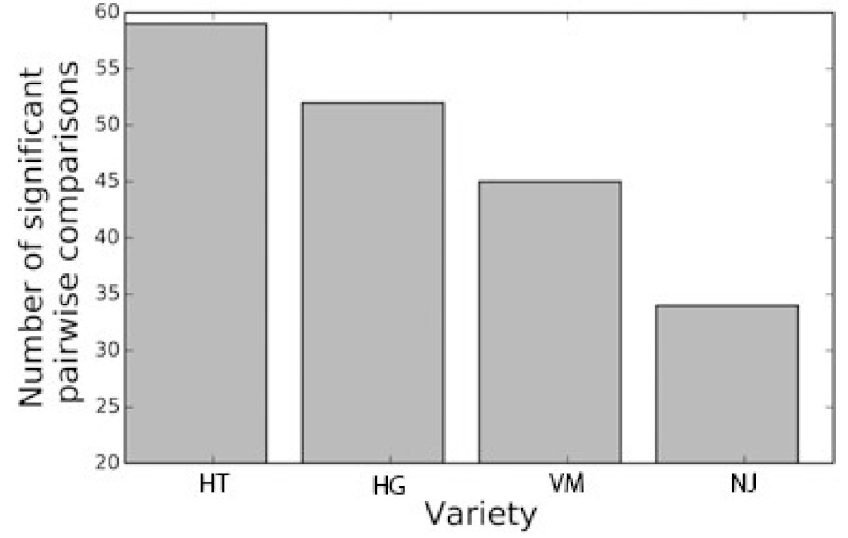
Figure 4. Permutation testing example for compound 1 . The empirical distribution of the F-statistic established by permutations for this compound can be seen in black. The value of the observed statistic is shown in gray. Abbreviations: HT, HT-801; HG, hybrid green F1; NJ, NJ-953; VM, “verde